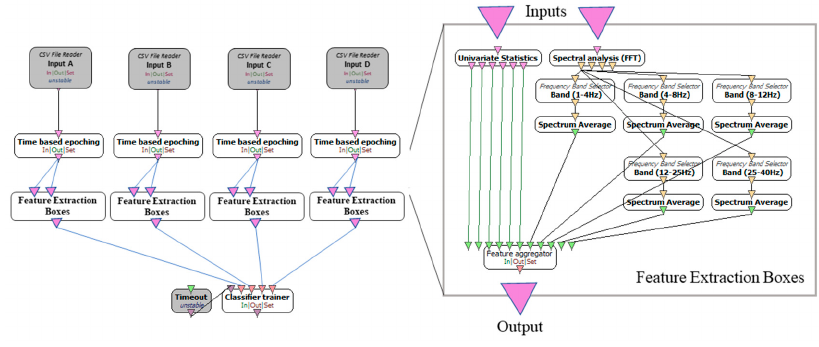
Figure 2. The OpenViBE training scenario of the analysis.